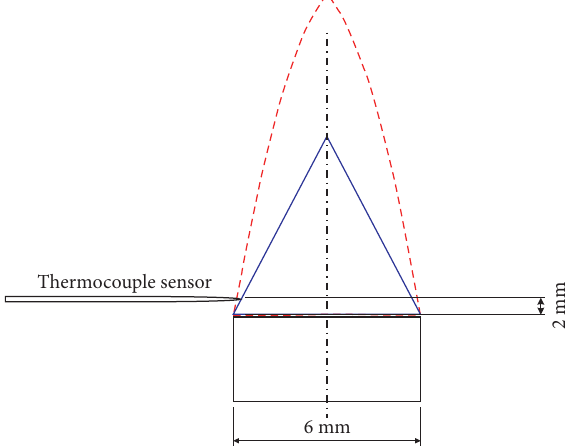
Figure 3: Thermocouple